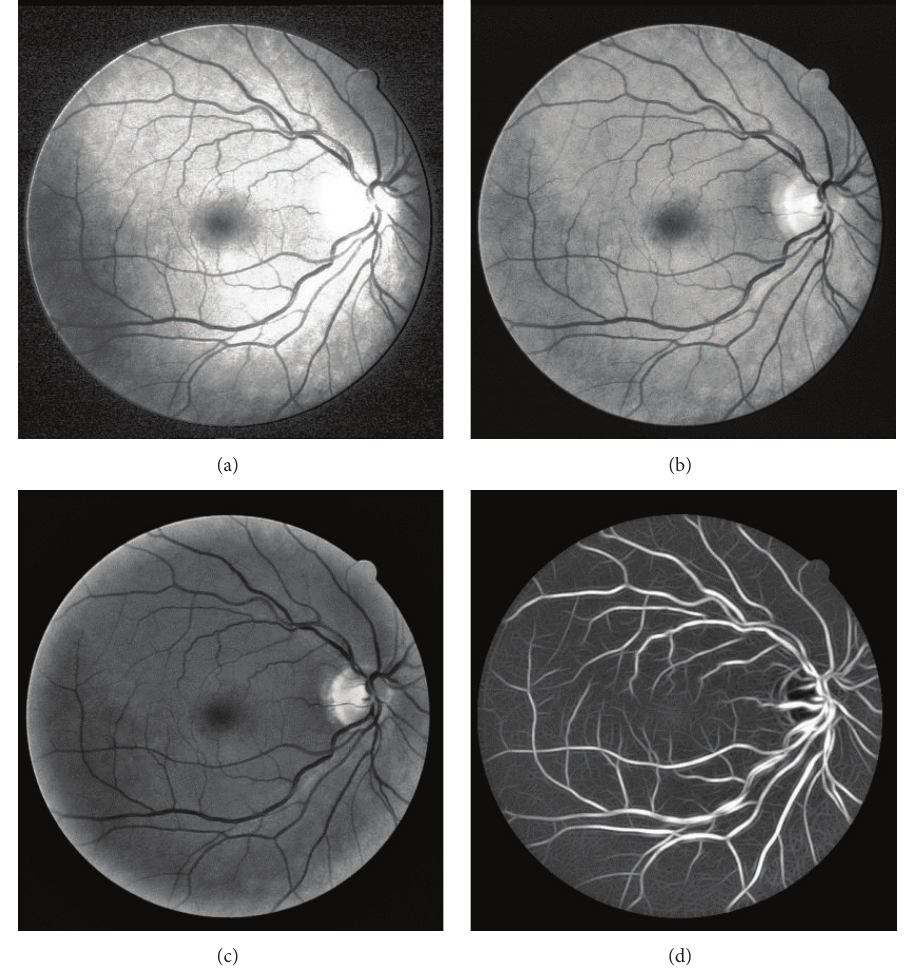
Figure 7: The enhancement results with different methods. (a) The enhancement result using HE; (b) the enhancement result using CLAHE; (c) the enhancement result using method in [7]; (d) the enhancement result using method in [9]. Table 2: The comparison of CII and r with different methods on the images shown in Figure 8. Evaluation Image HE CLAHE Method in [7] Method in [9] measures